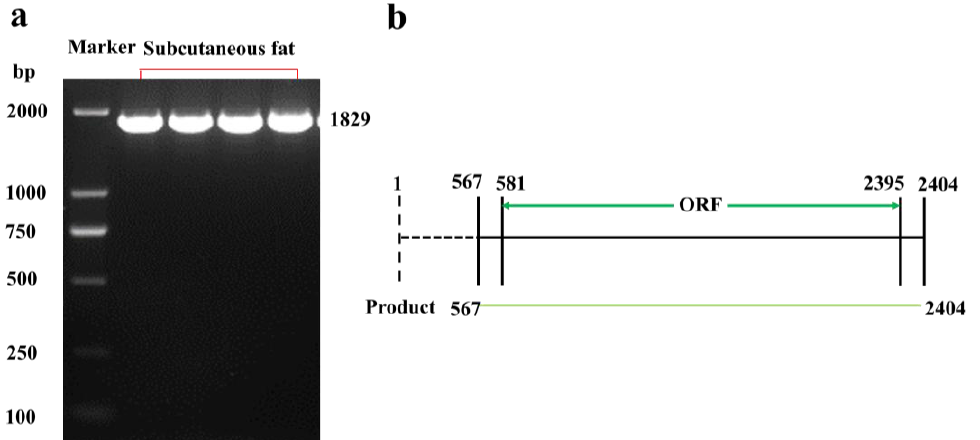
Figure 1. RUNX1T1-coding sequence (RUNX1T1-CDS) primers were designed for amplifying the open reading frame (ORF) of RUNX1T1 ( a ) and the sketch of RUNX1T amplification product from Hu lamb ( b ). The four lanes in the red bracket represented RUNX1T1 amplification product using subcutaneous fat cDNA ( a ). The dashed line represents the 5′ untranslated region of RUNX1T1 ( b ) .